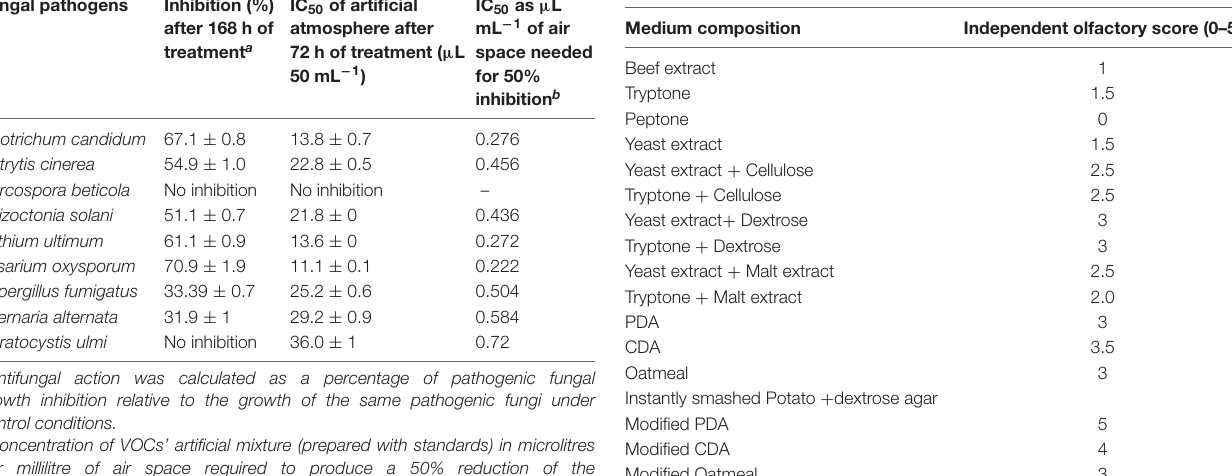
Frontiers in Microbiology |